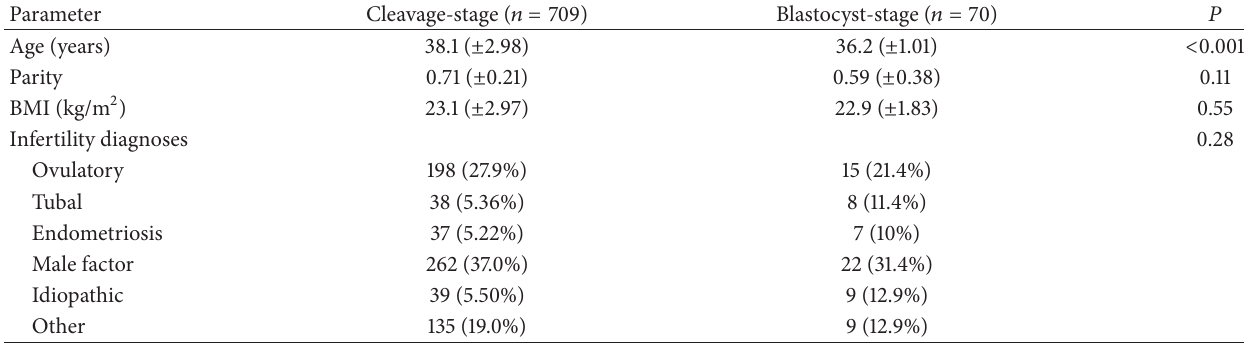
Table 1: Baseline demographics of patients undergoing cleavage-stage ETs ( 𝑛 = 709 ) or blastocyst-stage ETs ( 𝑛 = 70 ) with early VT.